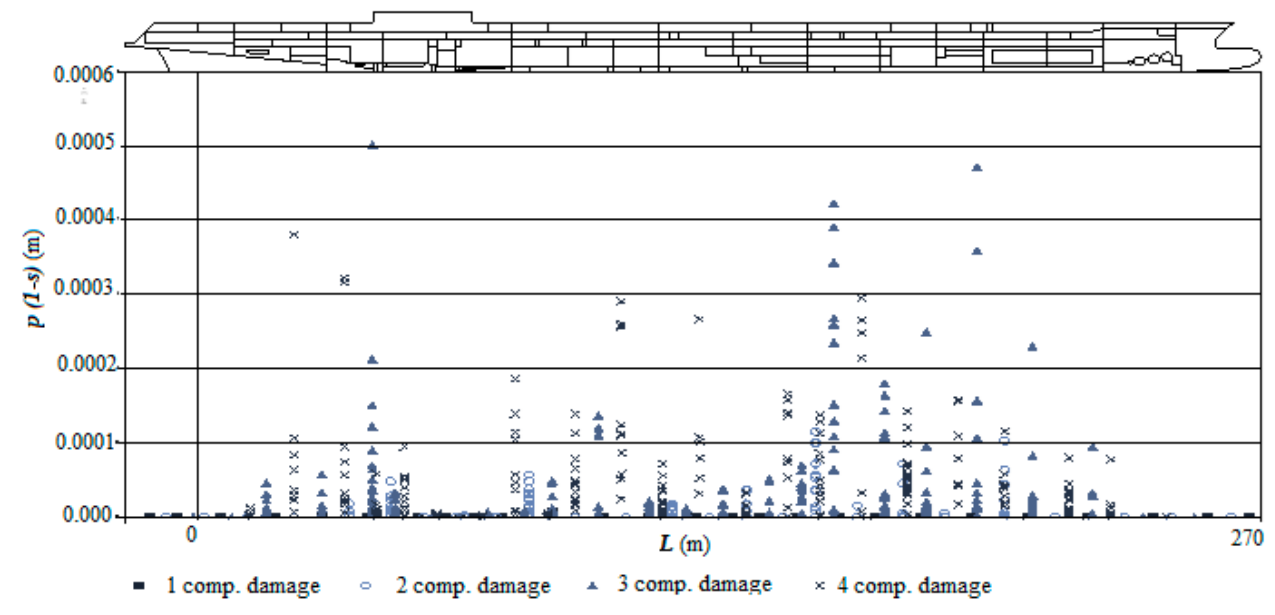
Figure 17. Static risk profile for cruise ship C1 with original layout.